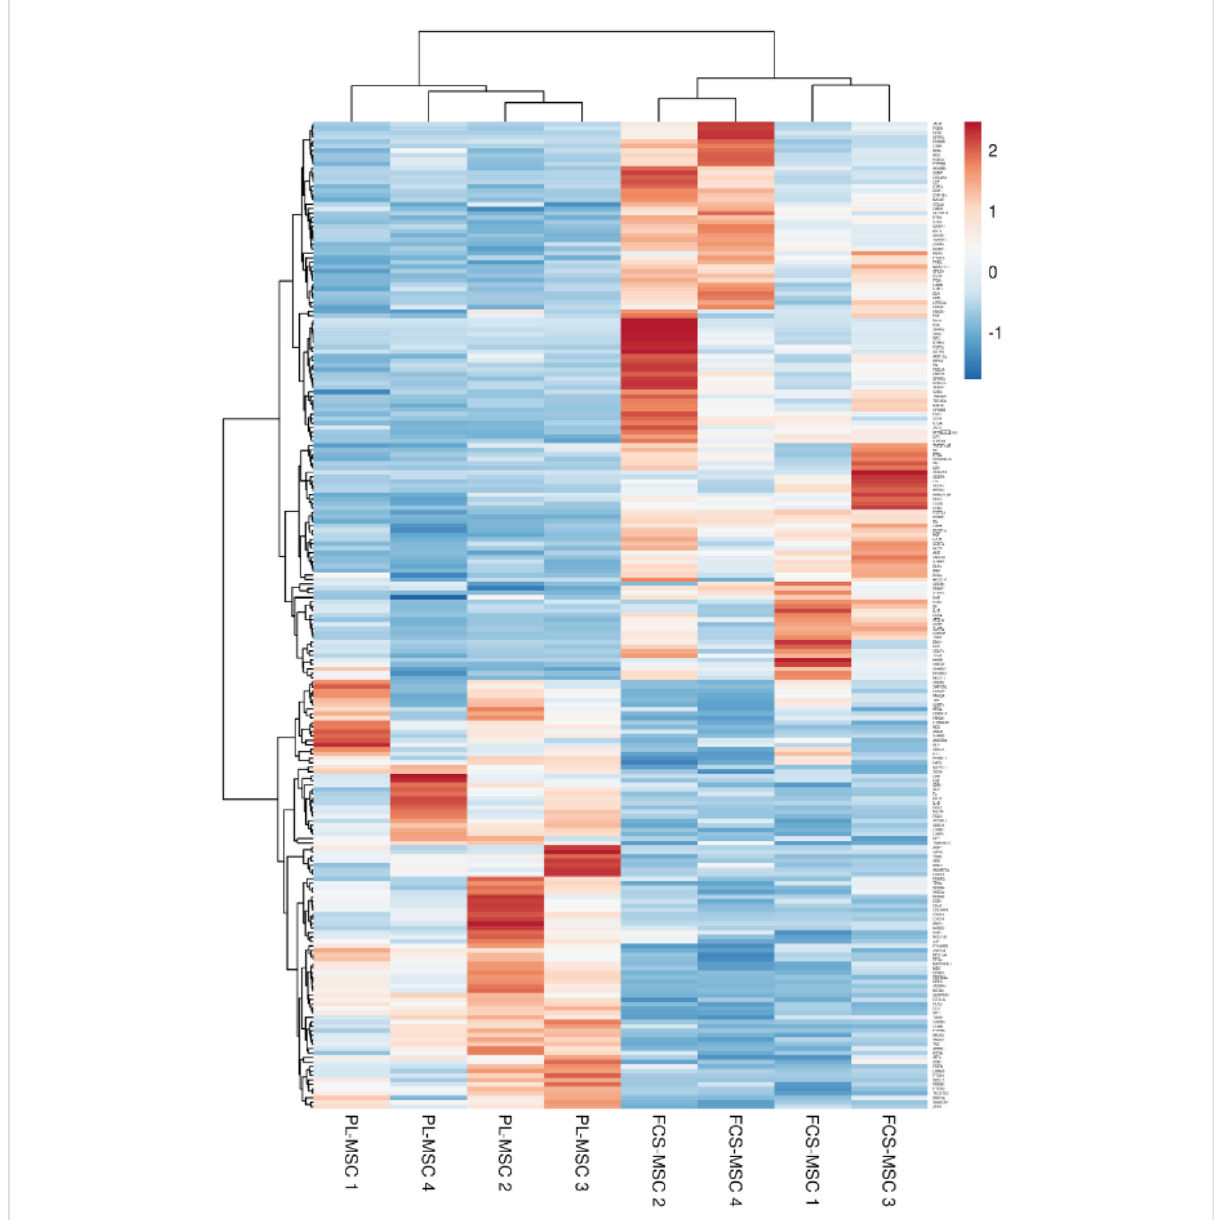
FIGURE 4 Heatmap generated based on FPKM of the 221 genes included in the Gene Ontology term ‘ regulation of cell population proliferation ’ (GO: 004212). Rows are centered and unit variance scaling is applied to the rows. Both rows and columns are clustered using correlation distance and average